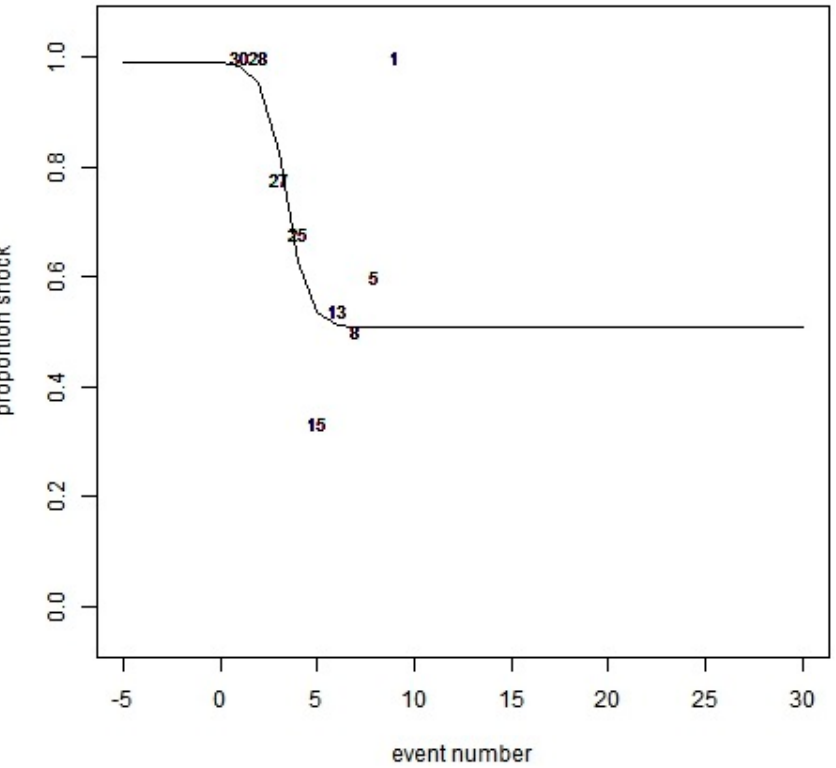
Figure 2. Logistic curve for the associative learning trial. Y-Axis is the proportion of animals that receive a stimulus following an audio cue. X-Axis is number of attempts to enter the exclusion zone throughout the entire testing period. The numerals are the number of animals that approached the exclusion zone for that event number. Event is defined as one interaction with the virtual fence determined by application of an audio cue. Table 1. Estimated parameters for the logistic regression curves for 30 sheep during associative learning. The upper asymptote indicates the proportion of naïve animals that received a stimulus during these events. The lower asymptote is the proportion of animals that continued to receive a stimulus. The difference between these is tested for significance. The point of inflection is the mean number of attempts it takes for half of the learning to occur. The slope indicates the speed of transition from the upper to lower asymptote. Upper Asymptote Lower Asymptote Sig Diff Point of